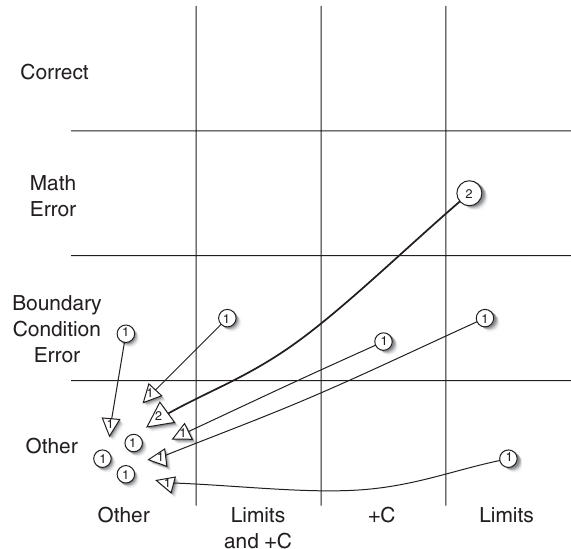
FIG. 10. Attractor pattern representing a subset of data from Fig. 7. Students move toward one region on the consistency plot.